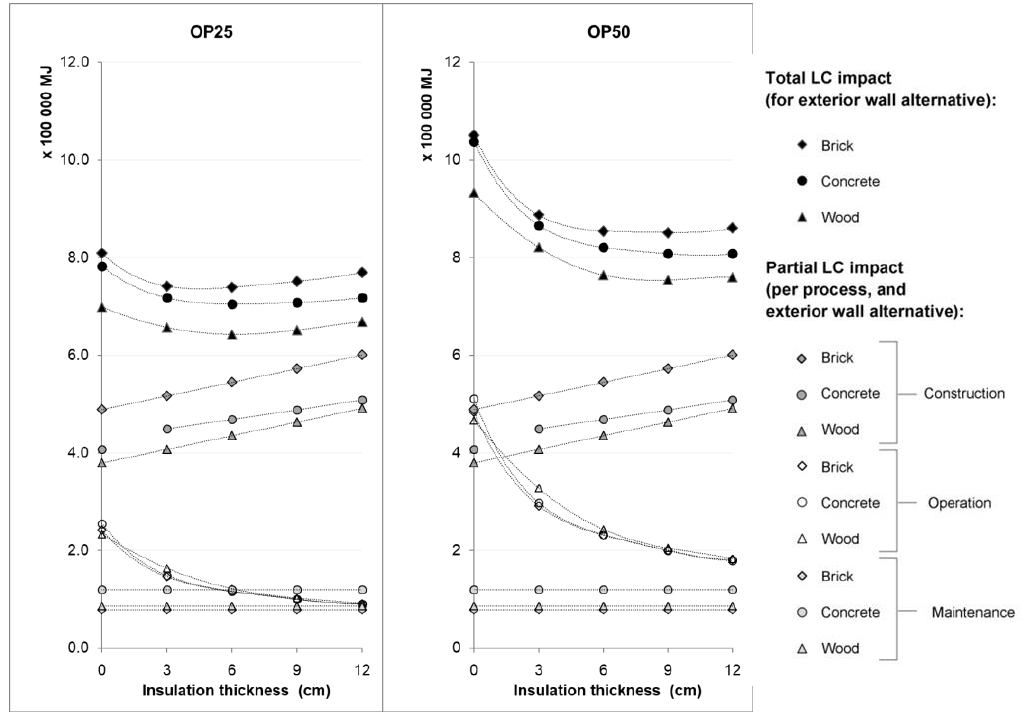
Figure 4 . NRPE for OP25 and OP50 for exterior wall house alternatives (brick, concrete, and wood) vs. insulation level.